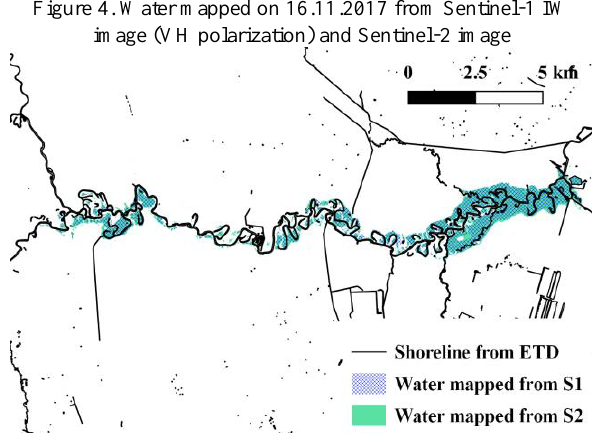
Figure 4. Water mapped on 16.11.2017 from Sentinel-1 IW